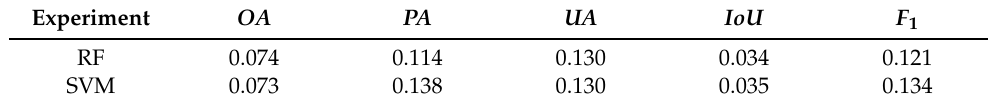
Table 5. Global metrics for the experiments with RF and SVM on UOPNOA. Experiment OA